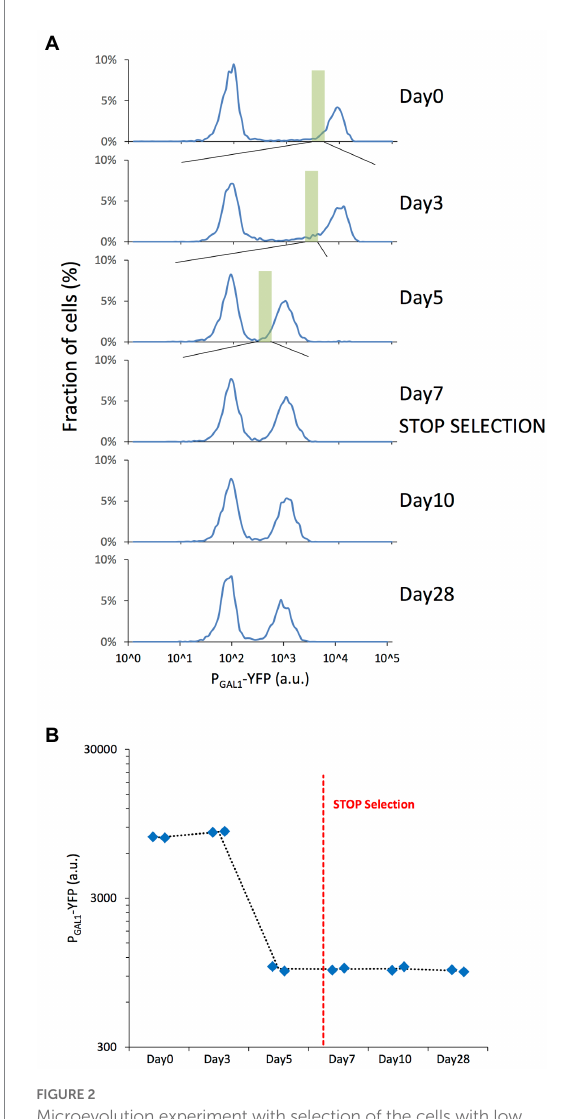
FIGURE 2 Microevolution experiment with selection of the cells with low YFP expression. (A) P GAL1 -driven YFP expression distributions of the revived yeast cells grown in 0.1% mannose & 0.2% galactose synthetic complete media, indicating the fraction of cells expressing different levels of YFP with cell fractions indicating normalization to the total number of cells plotted in each panel. The expression distributions correspond to the different days of the original evolution experiment. The green rectangle represents the selected/sorted population at each time point, corresponding to the lowest 5% of the YFP-ON cells. The peak left to the gray dashed line corresponds to OFF expression state of the bistable GAL network. (B) Mean P GAL1 -YFP expression of the ON cells was measured on selected days of the microevolution experiment. Blue diamonds represent the values of each replicate. The red dashed line represents the moment when selection pressure was